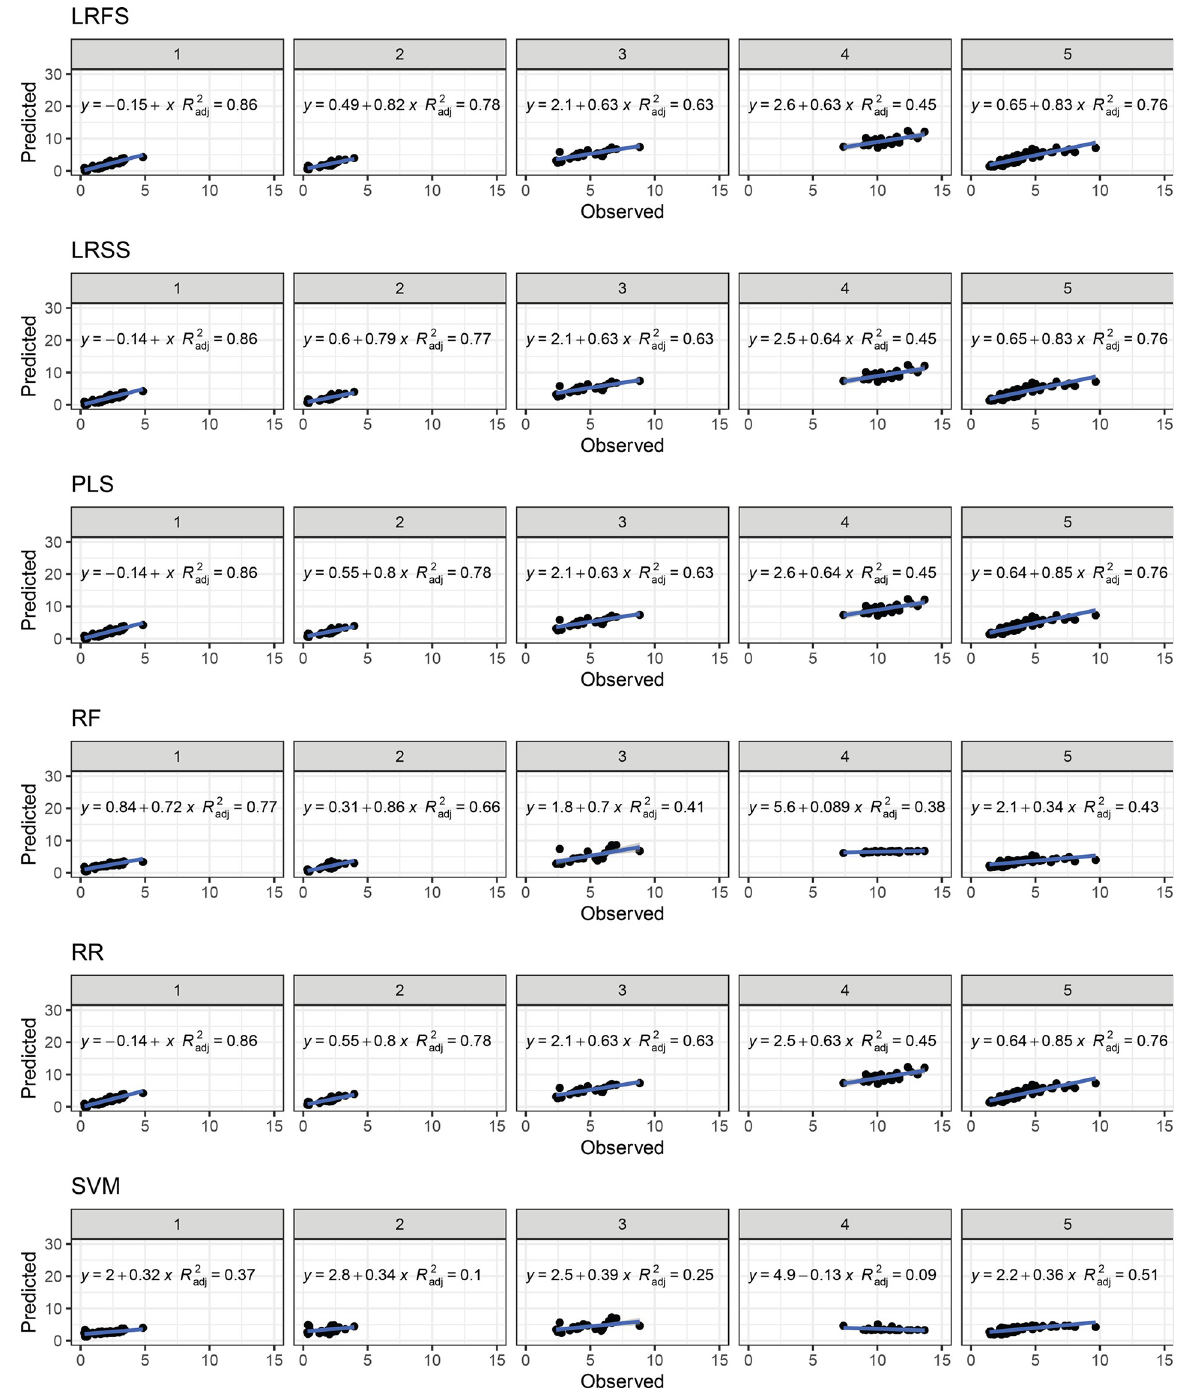
Fig 9. Relationship between observed and predicted values for total carotenoid content of cassava roots. The prediction was performed based on 12 different models based on PCA clustering-based with k = 5 (IV-Cluster). Linear Regression with Forward Selection (LRFS), Linear Regression with Stepwise Selection (LRSS), Partial Least Squares (PLS), Random Forest (RF), Ridge Regression (RR), and Support Vector Machine (SVM). The numerical data included in the graphs represent: linear equations (y) and coefficient of determination (R 2 ).